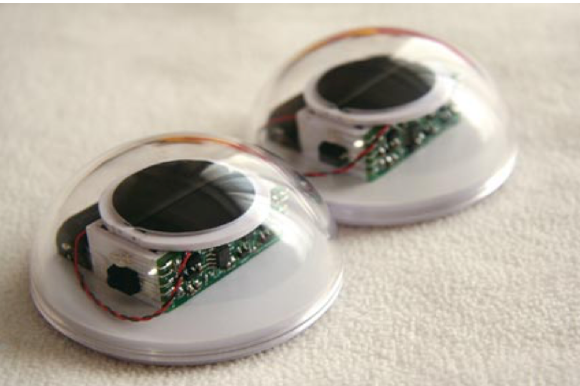
Figure 1 | Ryota Kuwakubo, Nicodama, 2009, Courtesy of the